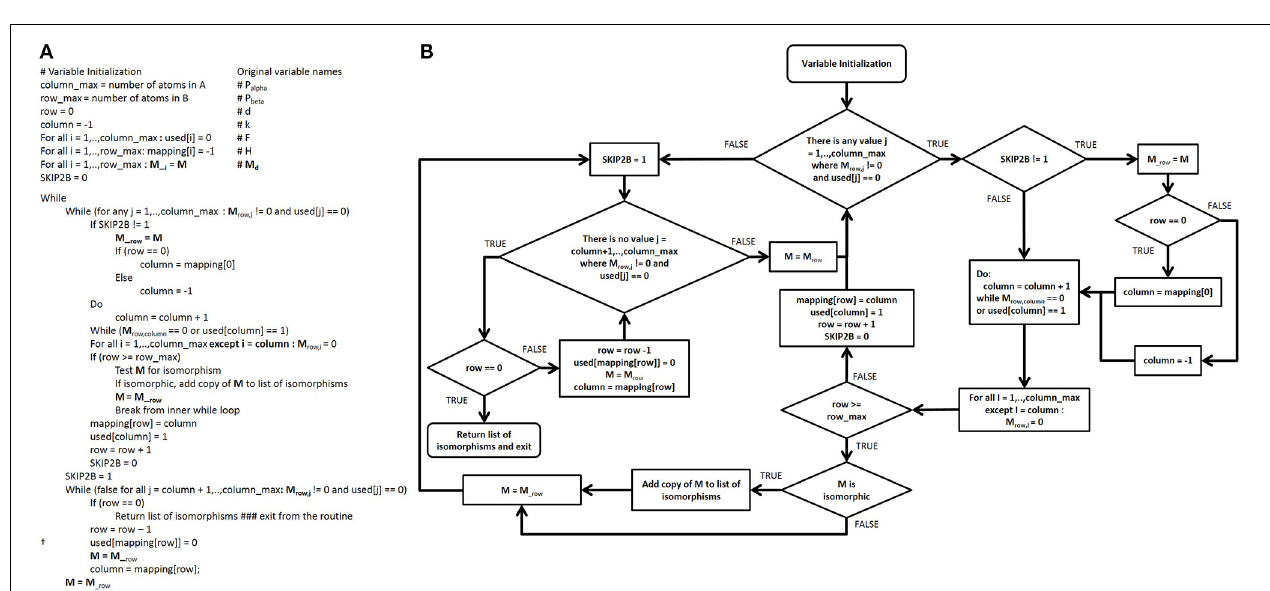
FIGURE 5 | Modernized pseudocode and control flow diagram of the Ullmann algorithm. (A) Modern Ullmann algorithm pseudocode produced from the control flow diagram with variables renamed to promote readability of the pseudocode. While converting the control flow